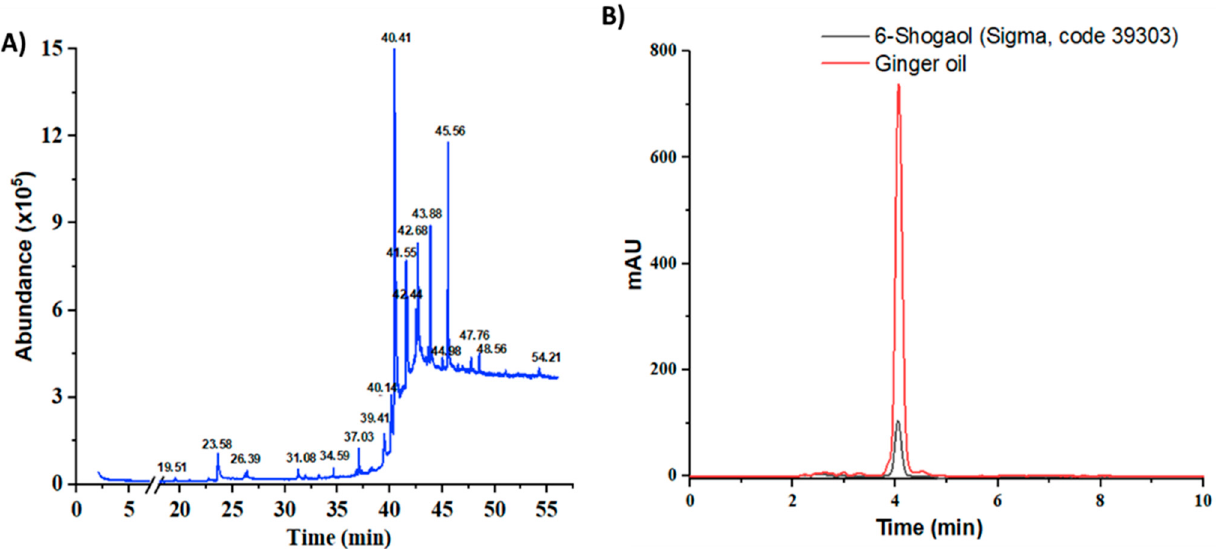
Figure 1. GC-MS chromatogram of edible ginger oil ( A ) and HPLC chromatograms of the representa- Figure 1. GC ‐ MS chromatogram of edible ginger oil ( A ) and HPLC chromatograms of the repre ‐ tive ginger oil extracts in compared to standard 6-shogaol ( B sentative ginger oil extracts in compared to standard 6 ‐ shogaol ( B ).